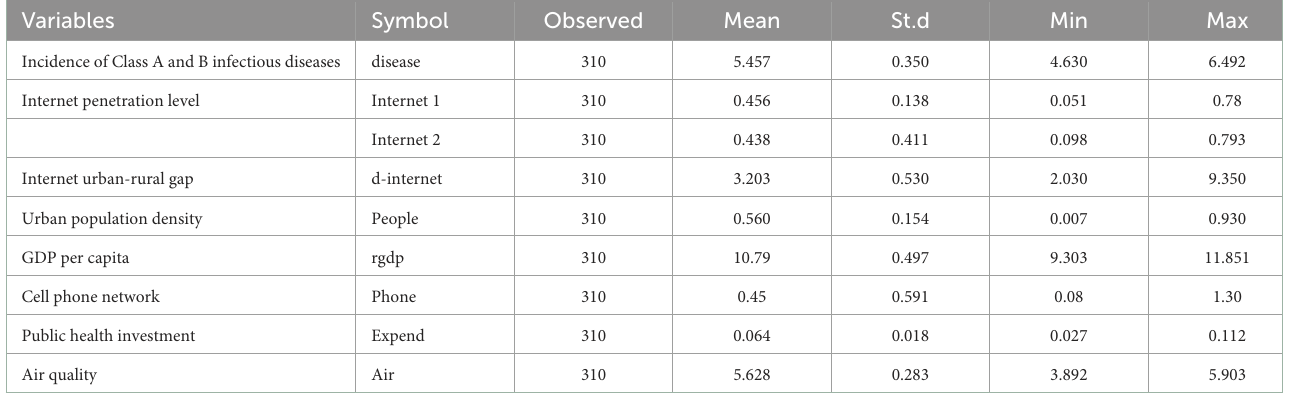
TABLE 1 Descriptive statistics of indicators by city and province.